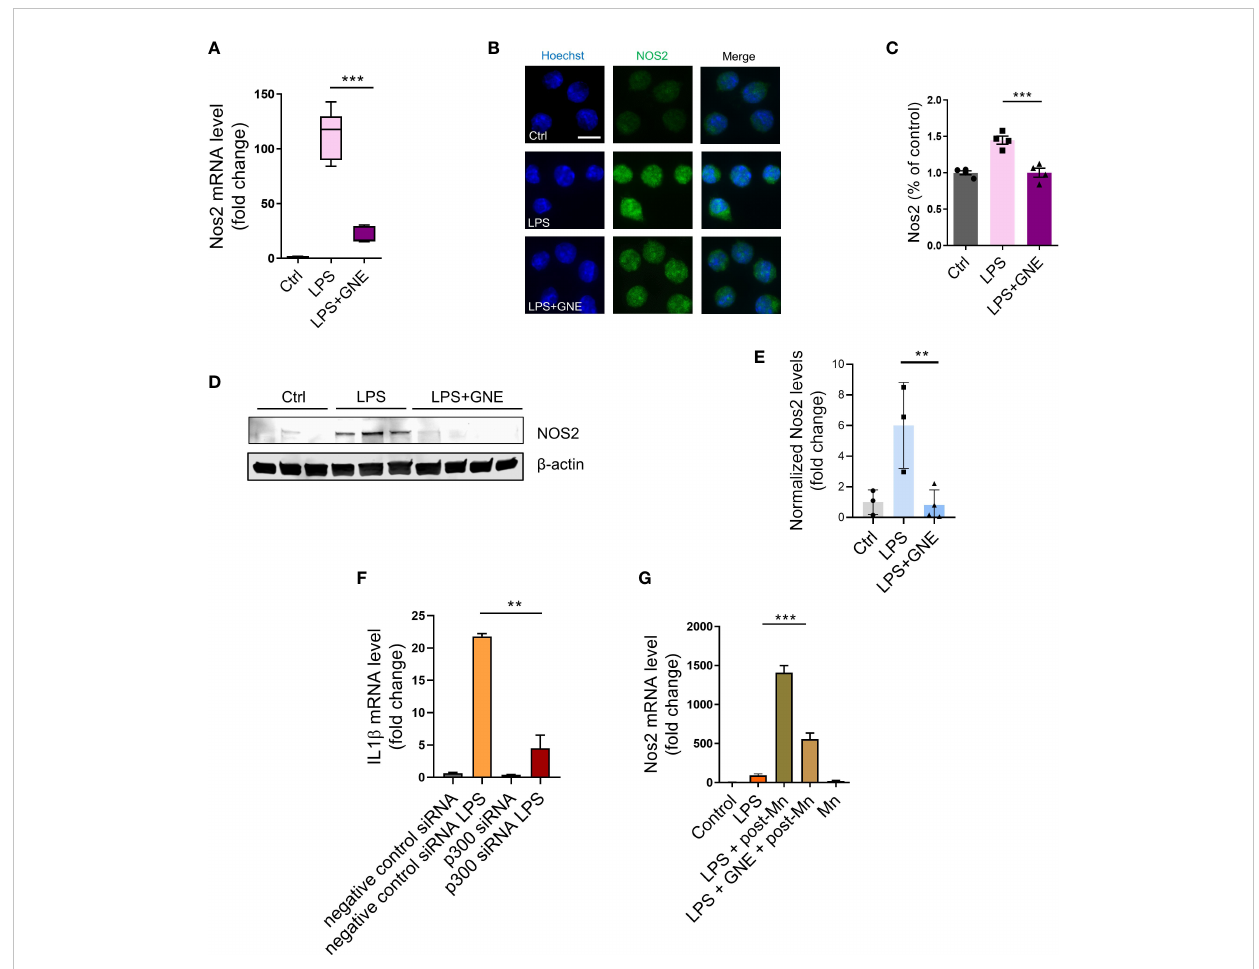
FIGURE 3 Inhibiting deposition of epigenetic mark H3K27ac through p300 suppresses iNOS signaling. (A) RT-qPCR analysis of Nos2 in primed MMC, indicating that the inhibitor GNE-049 decreased transcriptional expression of Nos2 by inhibiting p300/CBP. Two individual experiments (n=3) were performed. (B, C) Immuno fl uorescence microscopy analyses of Nos2 in GNE-049 co-treated, primed MMCs (n=4). Scale bar, 10 µm. Immunoblotting analyses of (D, E) Nos2 (n=3). (F) RT-qPCR analysis demonstrated that the relative expression levels of IL-1 b in p300 knockdown (KD) following LPS treatment, compared to MMC with negative control siRNA. (G) RT-qPCR analysis of Nos2 in primed MMC (n=4~12) following the treatment paradigm to examine the effects of GNE-049 on the transcription levels of Nos2 upon a secondary Mn insult. Data show mean±SEM of one-way ANOVA followed by Tukey ’ s post hoc test. Ctrl, control; **p<0.01;